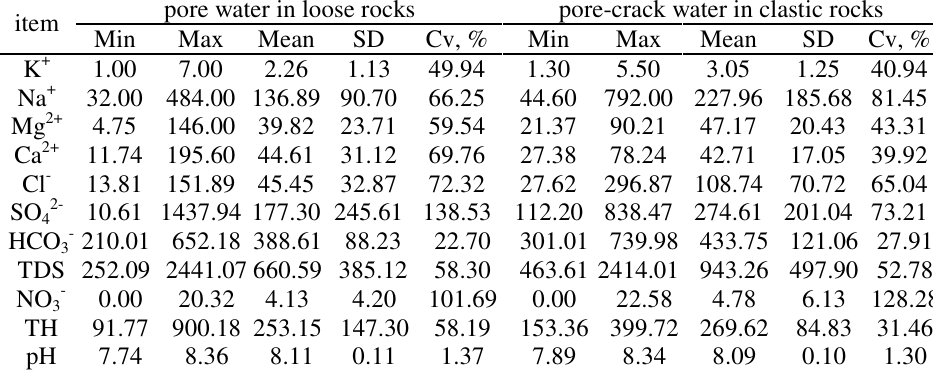
Table 1. Descriptive statistical eigenvalue of hydrochemical parameters of